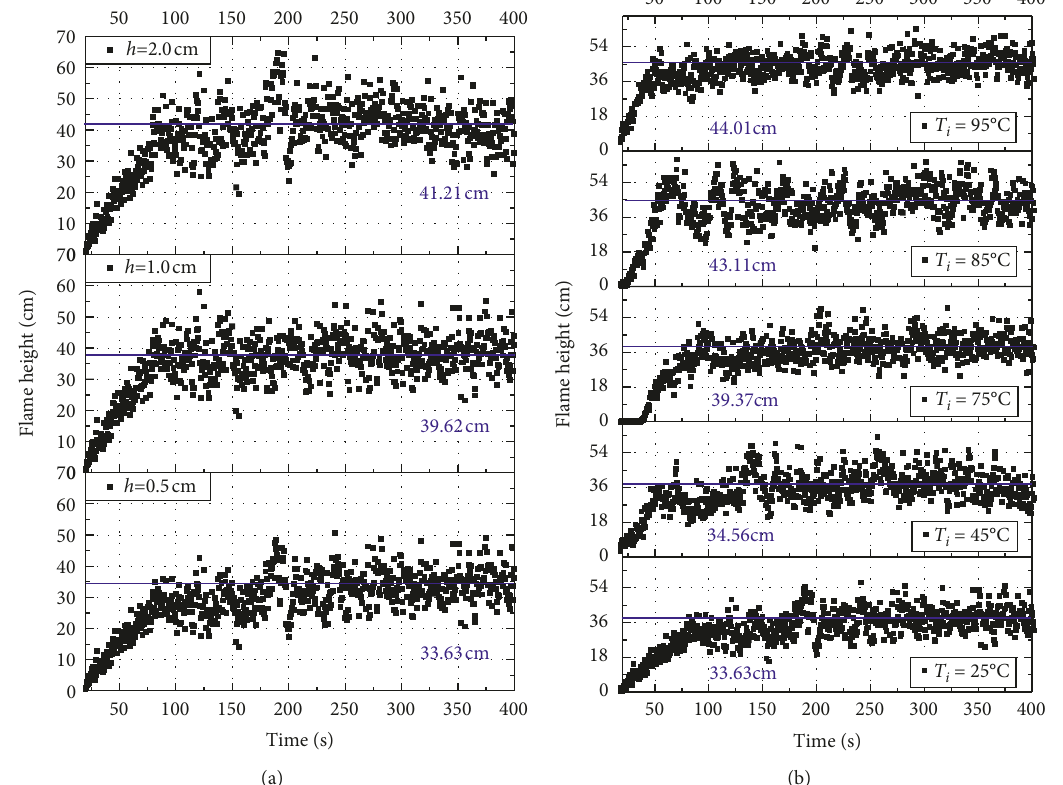
Figure 4: Variations of flame height as a function of time under different experimental conditions, (a) different fuel thicknesses, and (b) different initial